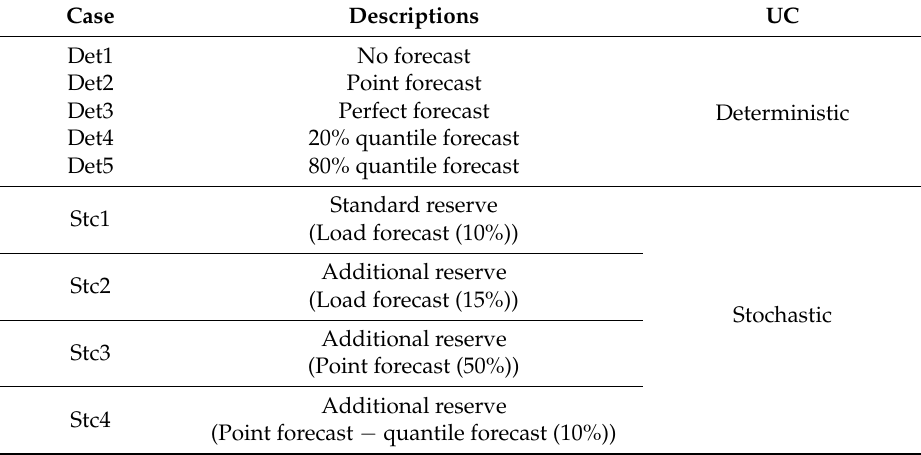
Table 3. Unit commitment (UC) strategies.